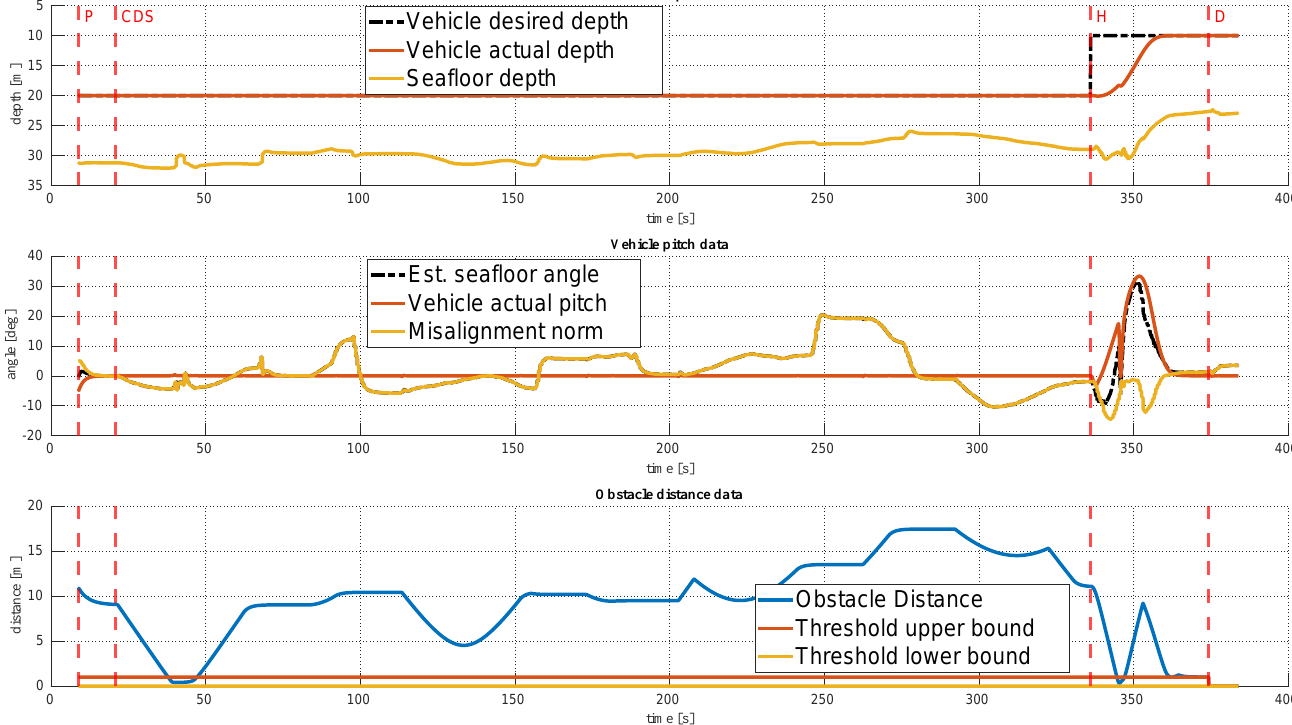
Figure 13. Constant depth mission: Time behavior of the vehicle depth, pitch, and obstacle avoidance data. The various phases of the mission are denoted in the plot as follows: P—Parking, CDS—Constant Depth Survey, H—Homing,